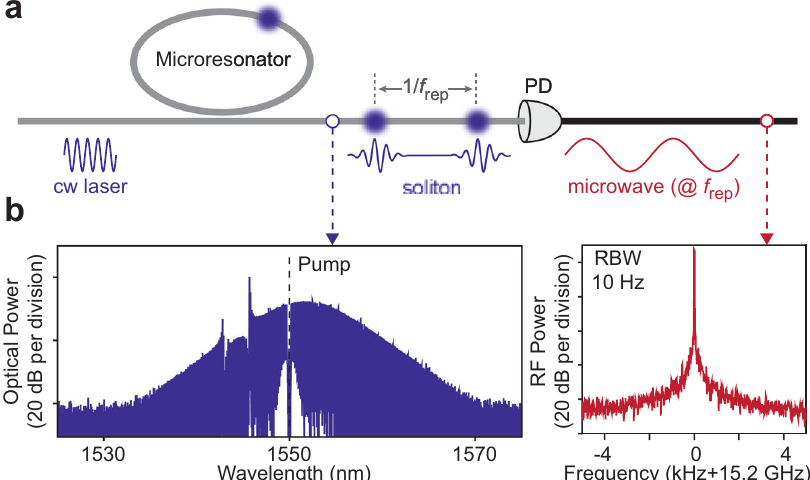
Fig. 1 Soliton microcombs as microwave signal sources. a Apparatus for microwave signal generation using a soliton microcomb. A microresonator pumped by a continuous-wave (cw) laser emits a repetitive soliton pulse train that is directed into a photodetector (PD) to produce a signal current. b Representative optical spectrum of a soliton microcomb with 15.2 GHz repetition rate (left panel). The pump (black dashed line) has been attenuated by an optical notch fi lter. The right panel shows the corresponding microwave-rate beat signal with resolution bandwidth (RBW) of 10